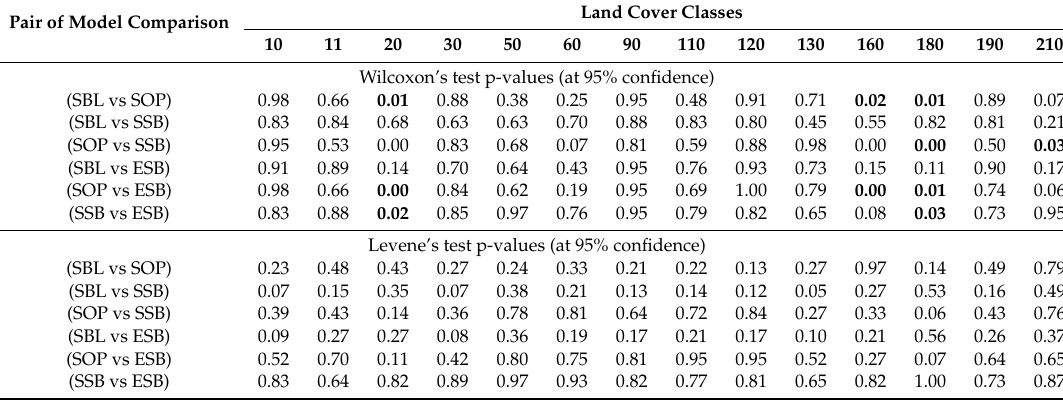
The nonparametric significance test (at a 95% confidence) (derived from the daily evapotranspiration estimates computed using Surface Energy Balance (SEB) model for a total of 25 MODIS satellite overpasses) for each pair of SEB models comparison for di ff erent land cover classes in the Kilombero Valley (KV) river basin. SBL, Surface Energy Balance Algorithm for Land (SEBAL) model; SOP, Operational Simplified Surface Energy Balance (SSEBop) model; SSB, Simplified Surface Energy Balance Index (S-SEBI) model; ESB, ensemble mean of daily ET estimates from the three models; ESA-CCI, European Space Agency Climate Change Initiative. The land cover classes’ values represent the standard values for land cover classes provided by ESA-CCI (refer to Table 3). Pair of Model